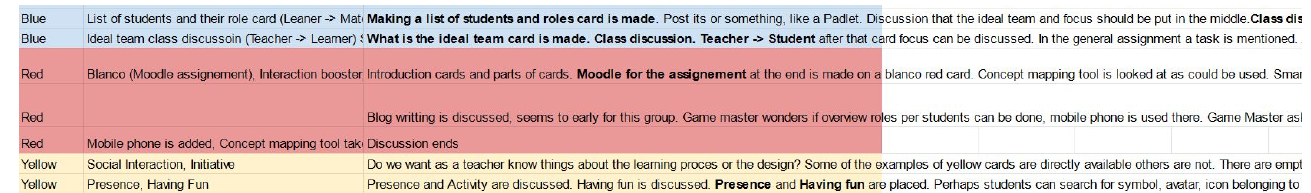
Figure 4. A sample annotation of the CC